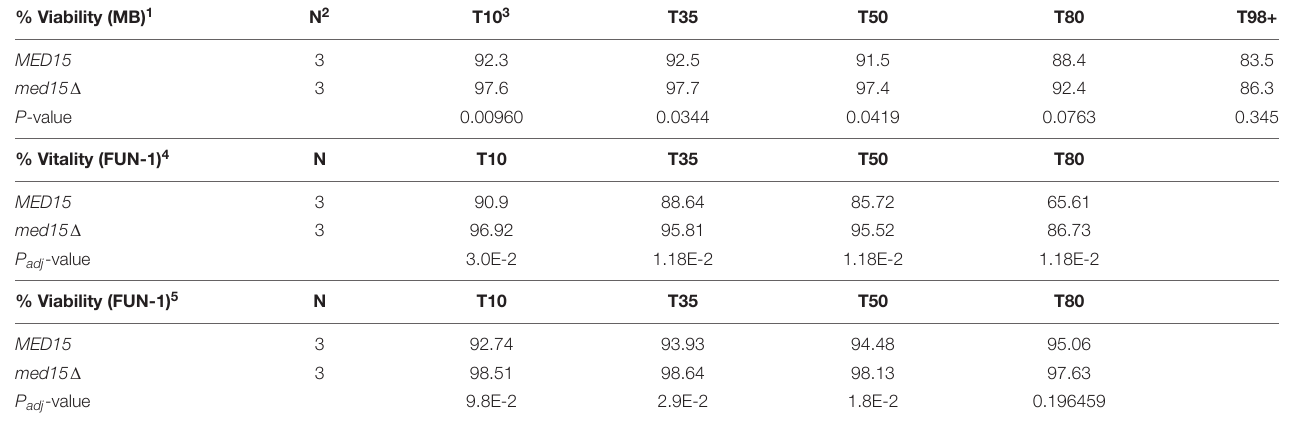
TABLE 3 | Viability and Vitality in WGJ-AA at Weight Loss Benchmarks.